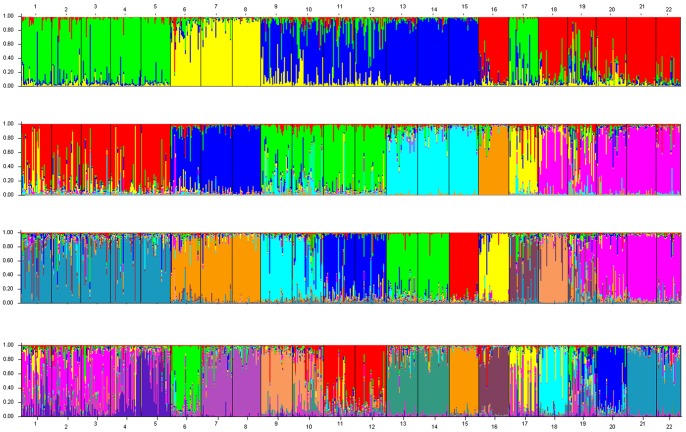
Clustering of 22 Siberian apricot populations.Each individual is shown as a vertical line divided into segments representing the estimated membership proportion in the four, seven, ten and fourteen ancestral genetic clusters inferred with STRUCTURE.